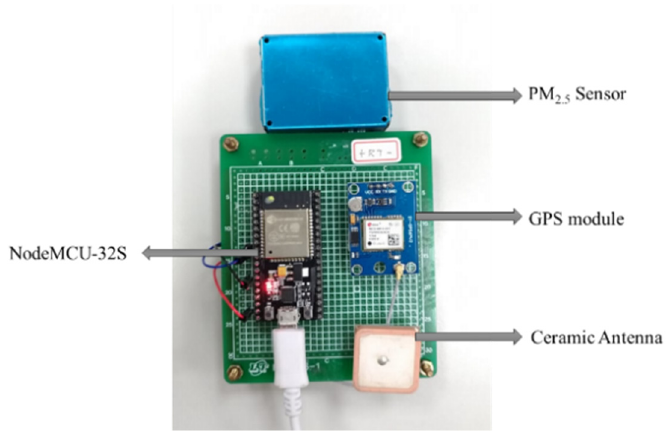
Figure 2. Hardware equipment.